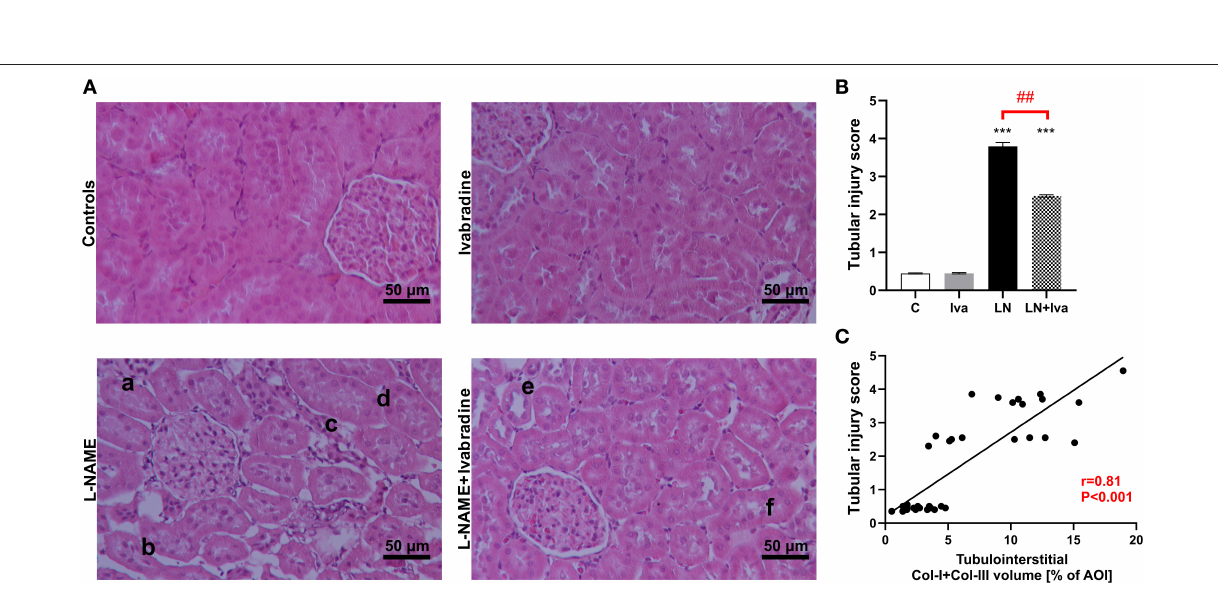
Frontiers in Medicine |